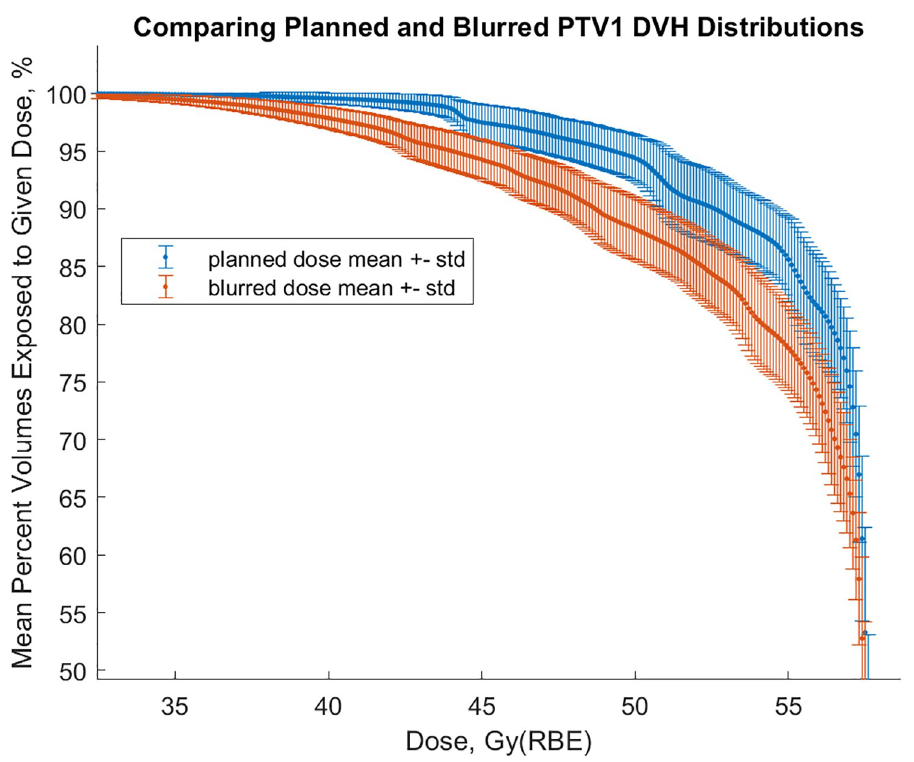
Fig 7. Comparison of mean planned and blurred PTV1 DVH from 40